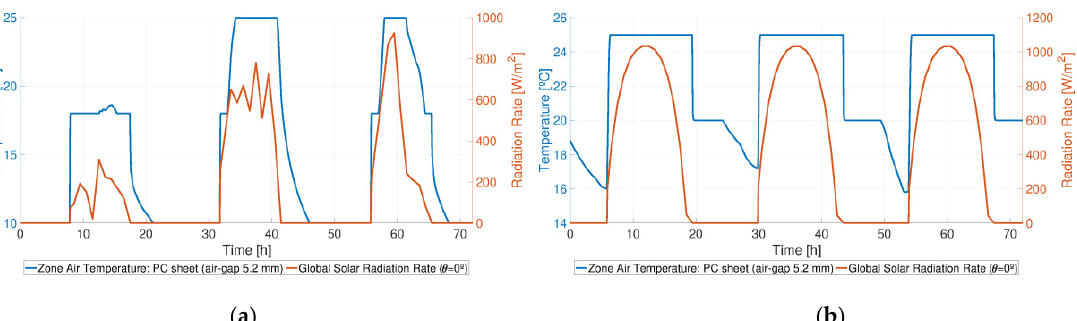
Figure 5. GHI and the conditioned temperature inside the greenhouse between the ( a ) 29 and 31 of January and the ( b ) 13 and 15 August.